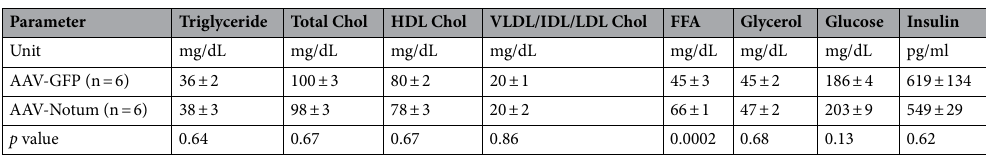
Table 2. Plasma lipids, lipoproteins, glucose, and insulin levels of mice that received AAV-GFP or AAV- Notum and fed a chow diet for 4 weeks. Values shown are means ± standard errors. Chol. Cholesterol, FFA Free fatty